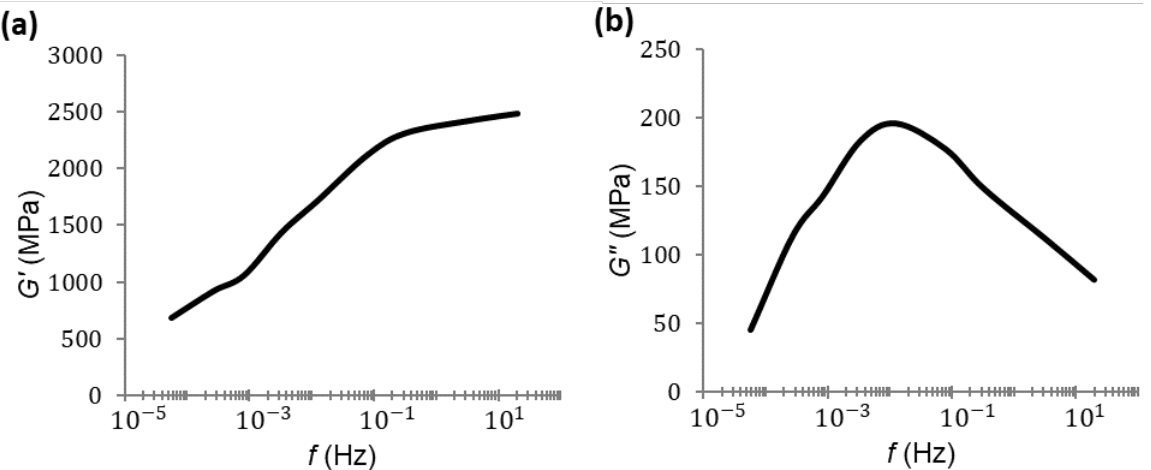
Figure 9. Master curve for the storage modulus ( a ) and loss modulus ( b ).